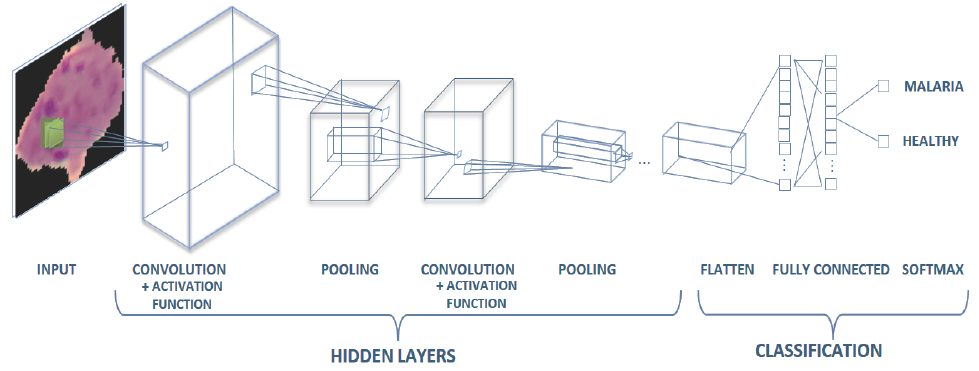
Figure 4. Convolutional neural network (CNN) model.